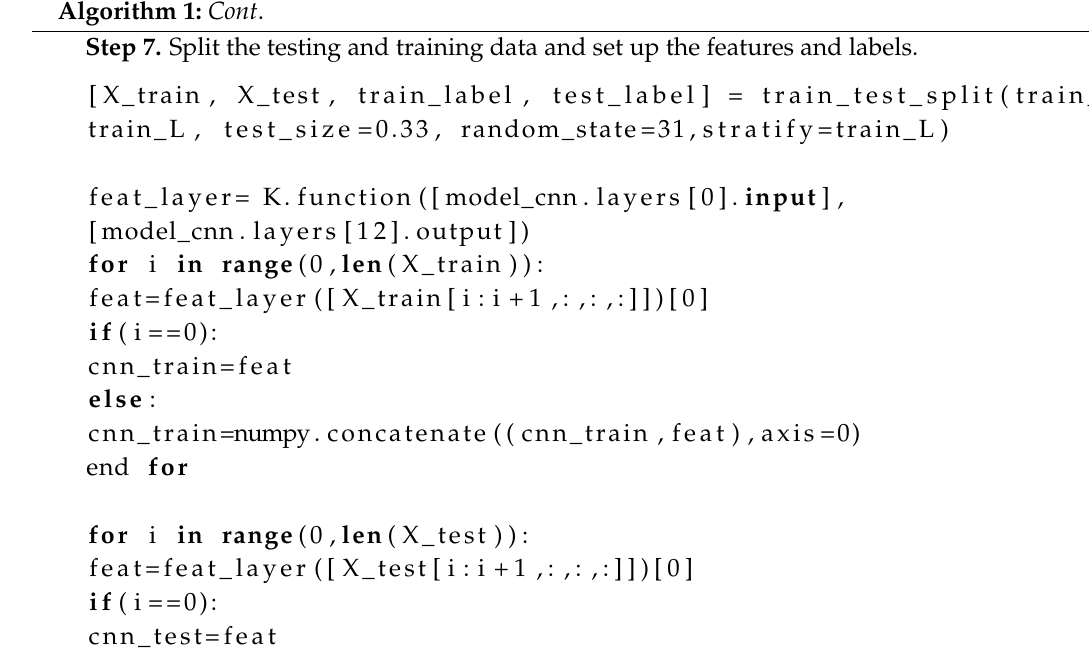
Algorithm 1: Cont